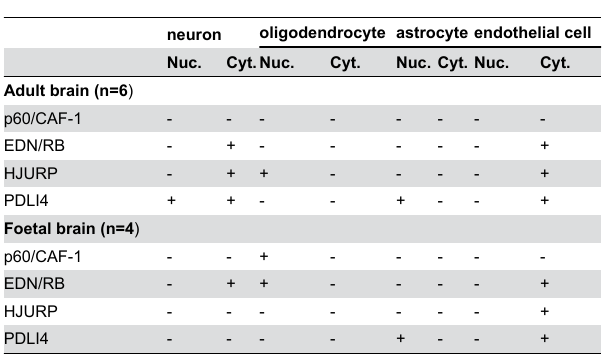
Table 3. Levels of EDN/RB, HJURP, p60/CAF-1 and PDLI4 proteins in adult and foetal brain, as determined by